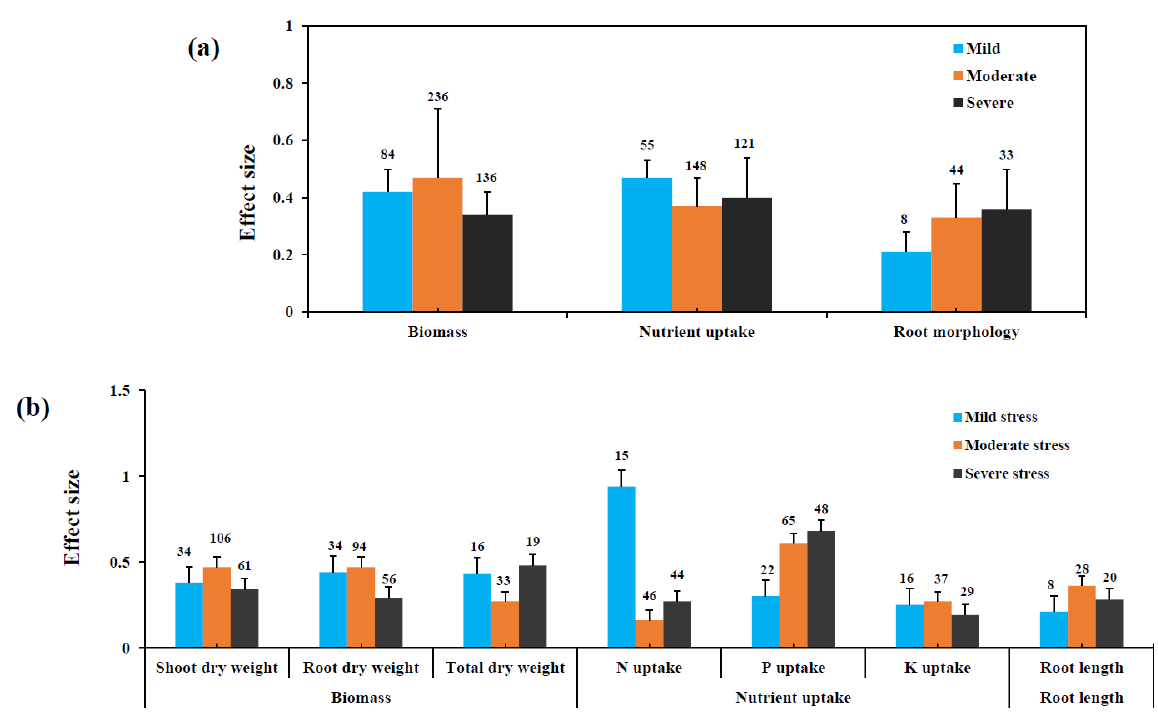
Figure 2. Effect of levels of drought stress on response variables. ( a ) Levels of stress on biomass, nutrient uptake, and root morphology. ( b ) Levels of stress on different response variables.